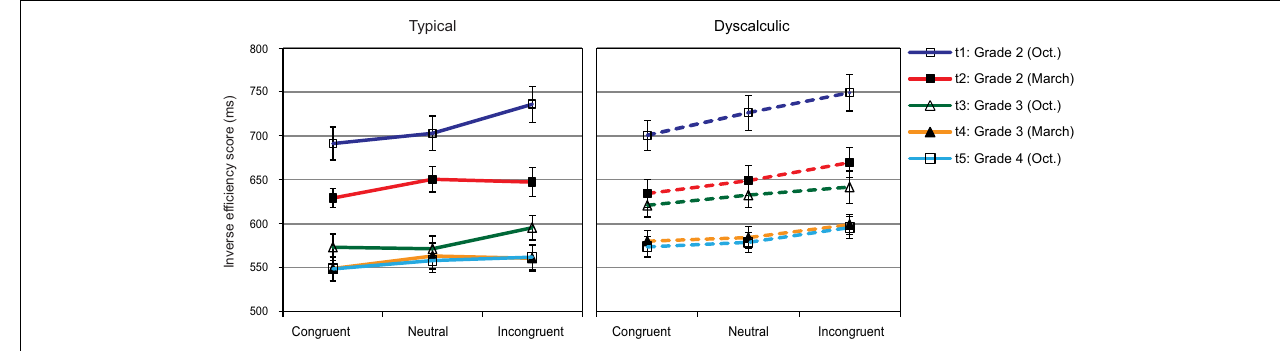
FIGURE 6 | Physical comparison: Mean IE-scores (SEs as error bars) for congruent, neutral, and incongruent items at each assessment point. systematically from t1 to t5 (all p s < 0.05). The only